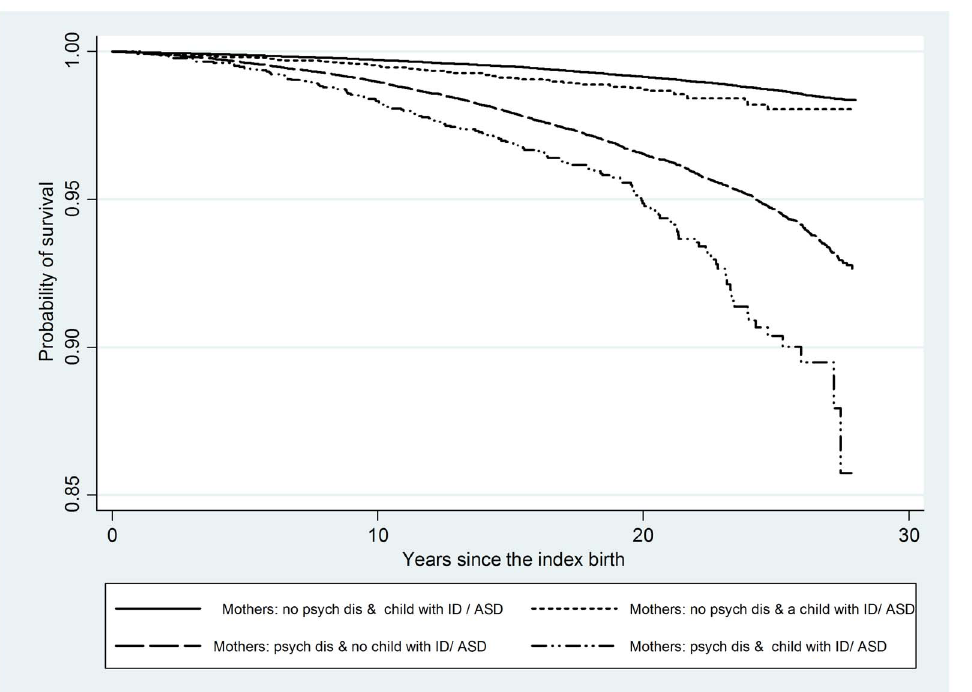
Fig. 4. Kaplan-Meier survival rates of mothers according to the existence of a psychiatric disorder and the disability status of the index